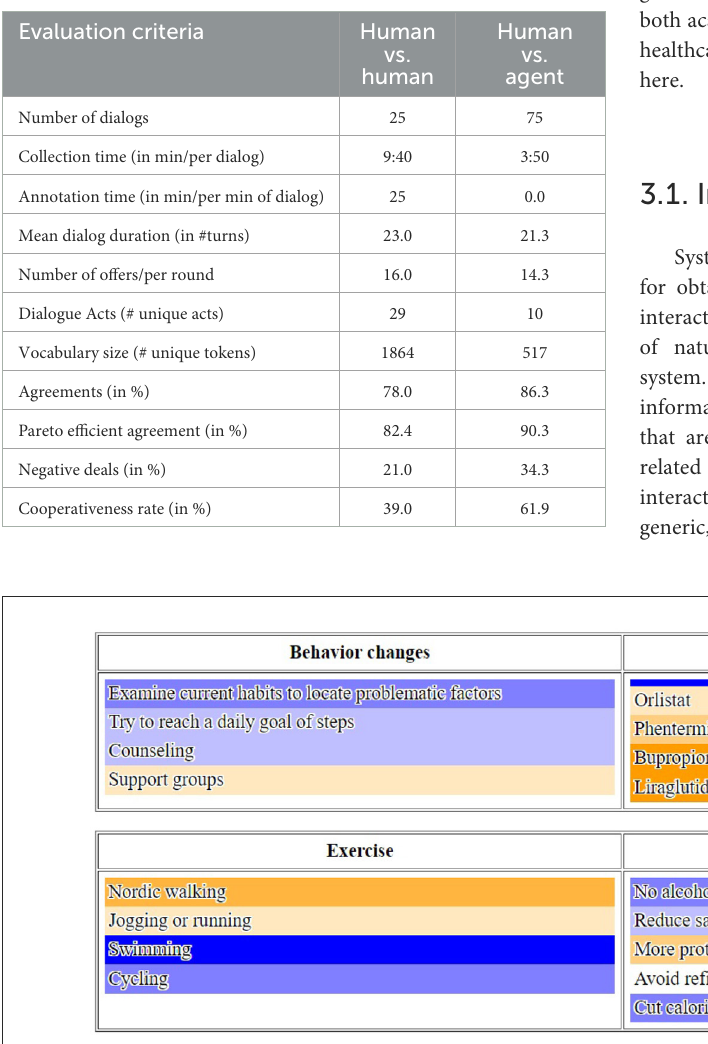
Human vs. vs. human agent